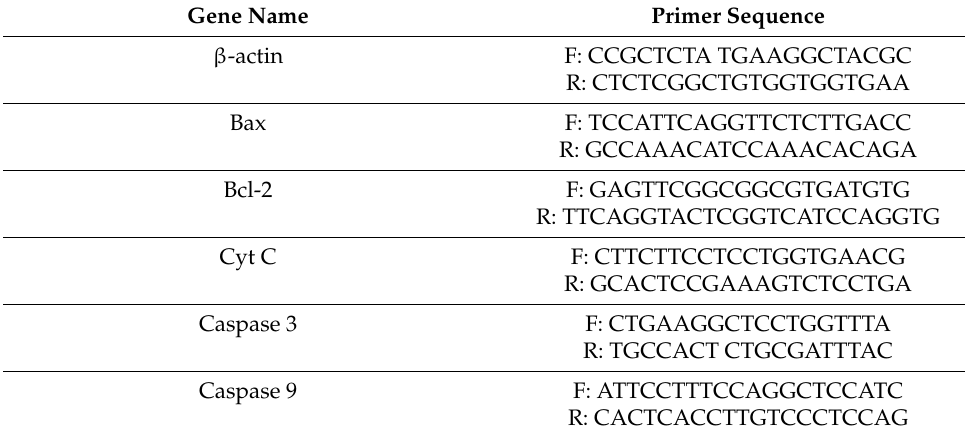
Table 1. Sequence of primers for real-time RT-PCR